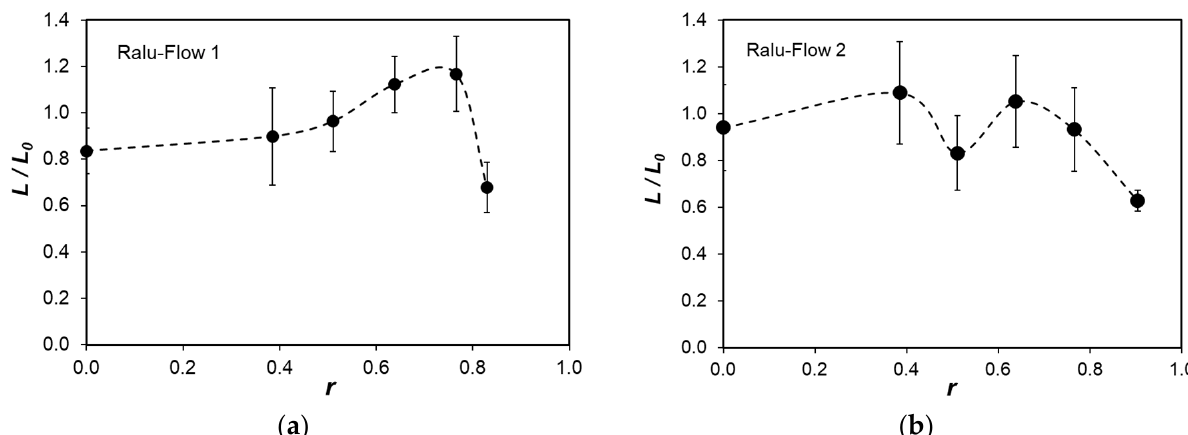
Figure 4. Relative local superficial velocity (collection sections 1–6, Table 1) in uniform initial distribution, L 0 = 3 · 10 − 3 m 3 m − 2 s − 1 , L 0 = 7 · 10 − 3 m 3 m − 2 s − 1 , L 0 = 12 · 10 − 3 m 3 m − 2 s − 1 : ( a ) Ralu–Flow 1; ( b ) Ralu–Flow 2.